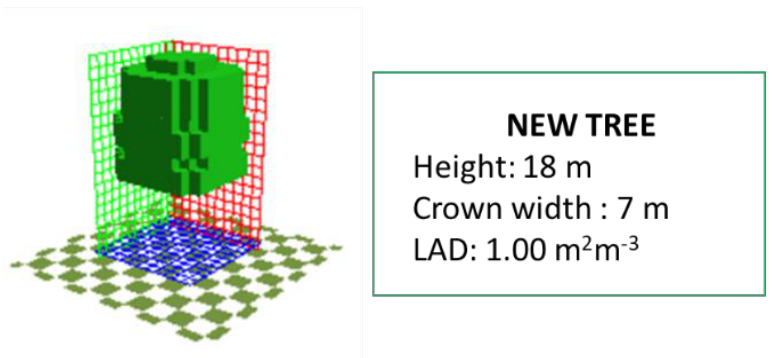
Figure 9. Modelling of the 3D study area in ENVI-met. ( Left ): No vegetation scenario; ( middle ): Current vegetation scenario; ( right ): Modified scenario.